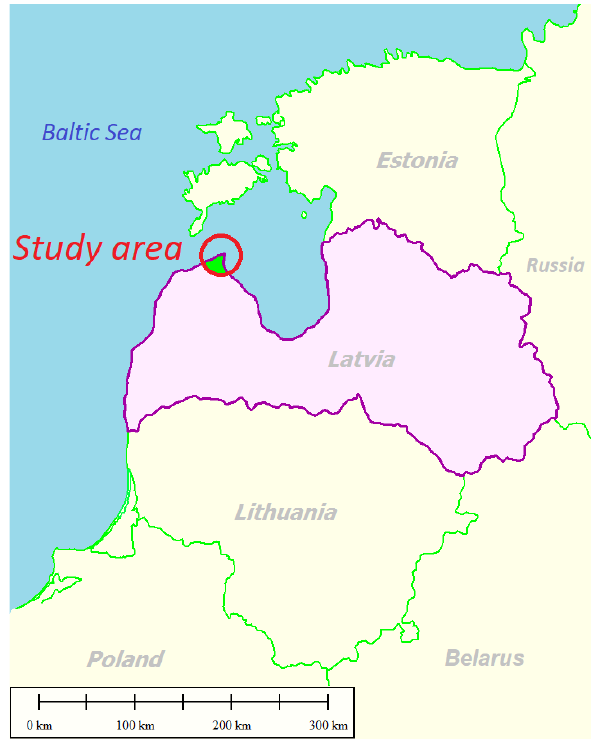
Figure 1. Map of the study